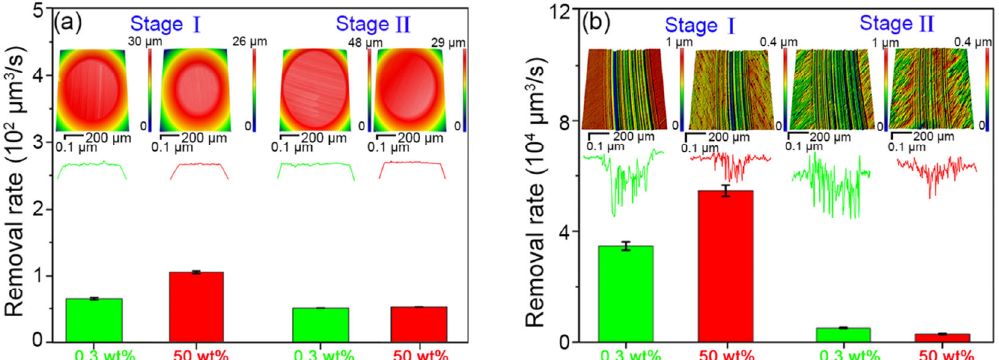
Fig. 4 Wear of (a) the steel balls and (b) substrates characterized at the end of Stages I and II under the oxygen content of ~0.3 and ~50 wt%. The upper insets in (a) and (b) show the three-dimensional topographies and corresponding cross-section profiles of the wear tracks formed after sliding with different running-in time on the steel balls and substrates. The error band represents a standard